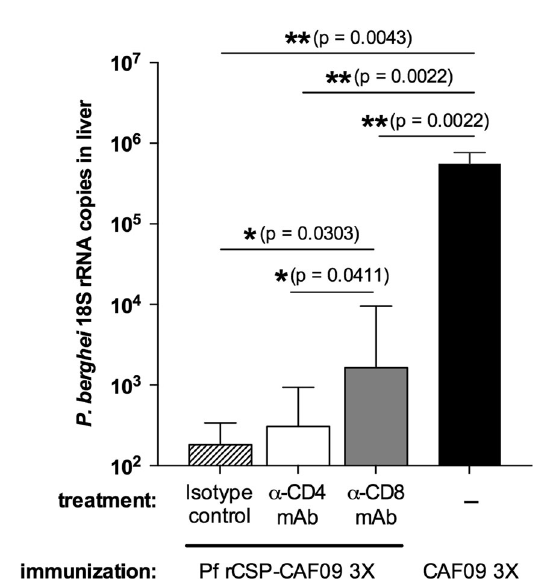
Fig. 5 P.b.-P.f. CD8CT transgenic sporozoite liver infection in T-cell depleted Pf rCSP-CAF09-immunized mice. Mice immunized three times with Pf rCSP-CAF09 had a dramatically lower parasite liver burden than those vaccinated with adjuvant only (CAF09 3×). The depletion of CD8 + T cells signi fi cantly impaired their capacity to inhibit parasite liver stages compared to mice treated with an isotype control antibody or with a CD4 + T-cell depleting antibody. Geometric mean with 95% con fi dence interval; n =